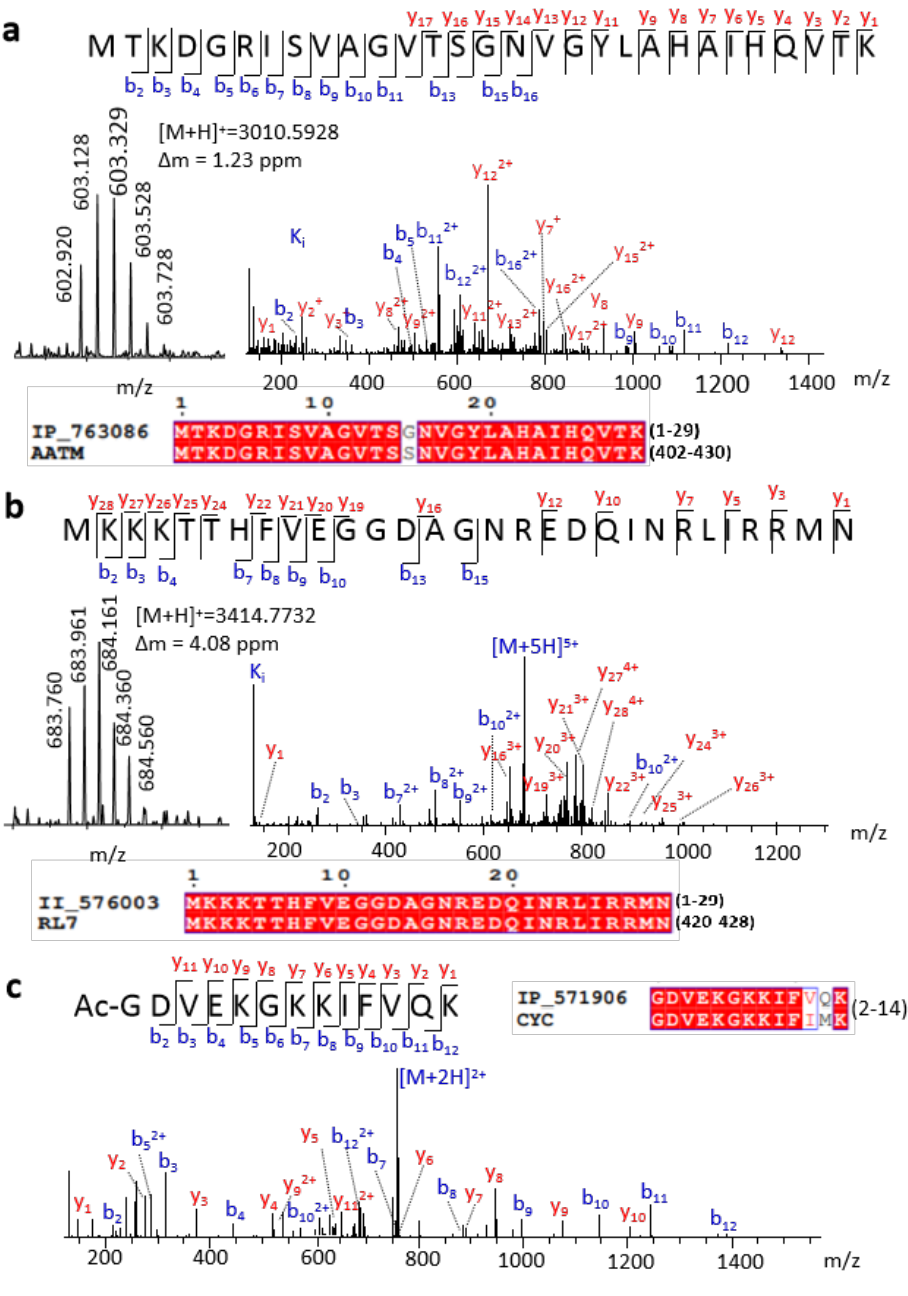
Figure 2. Representative SEPs identified by a top-down approach. Spectra and sequence alignment of ( a ) full length IP_763086, ( b ) full length II_576003, and ( c ) a peptide from IP_571906.